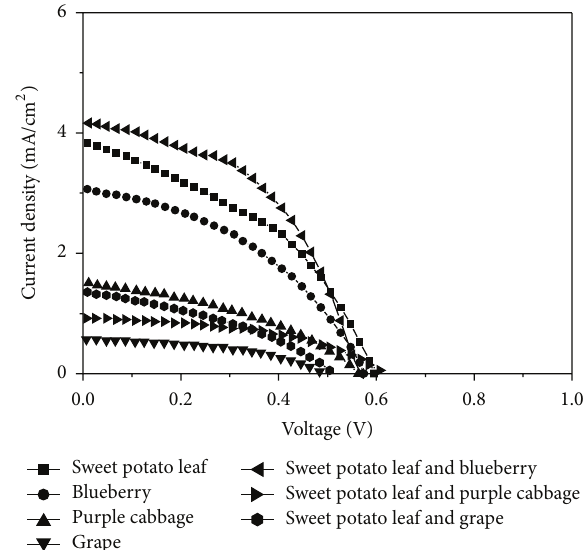
Figure 6: The photocurrent-voltage curves for natural dyes at a weight concentration of